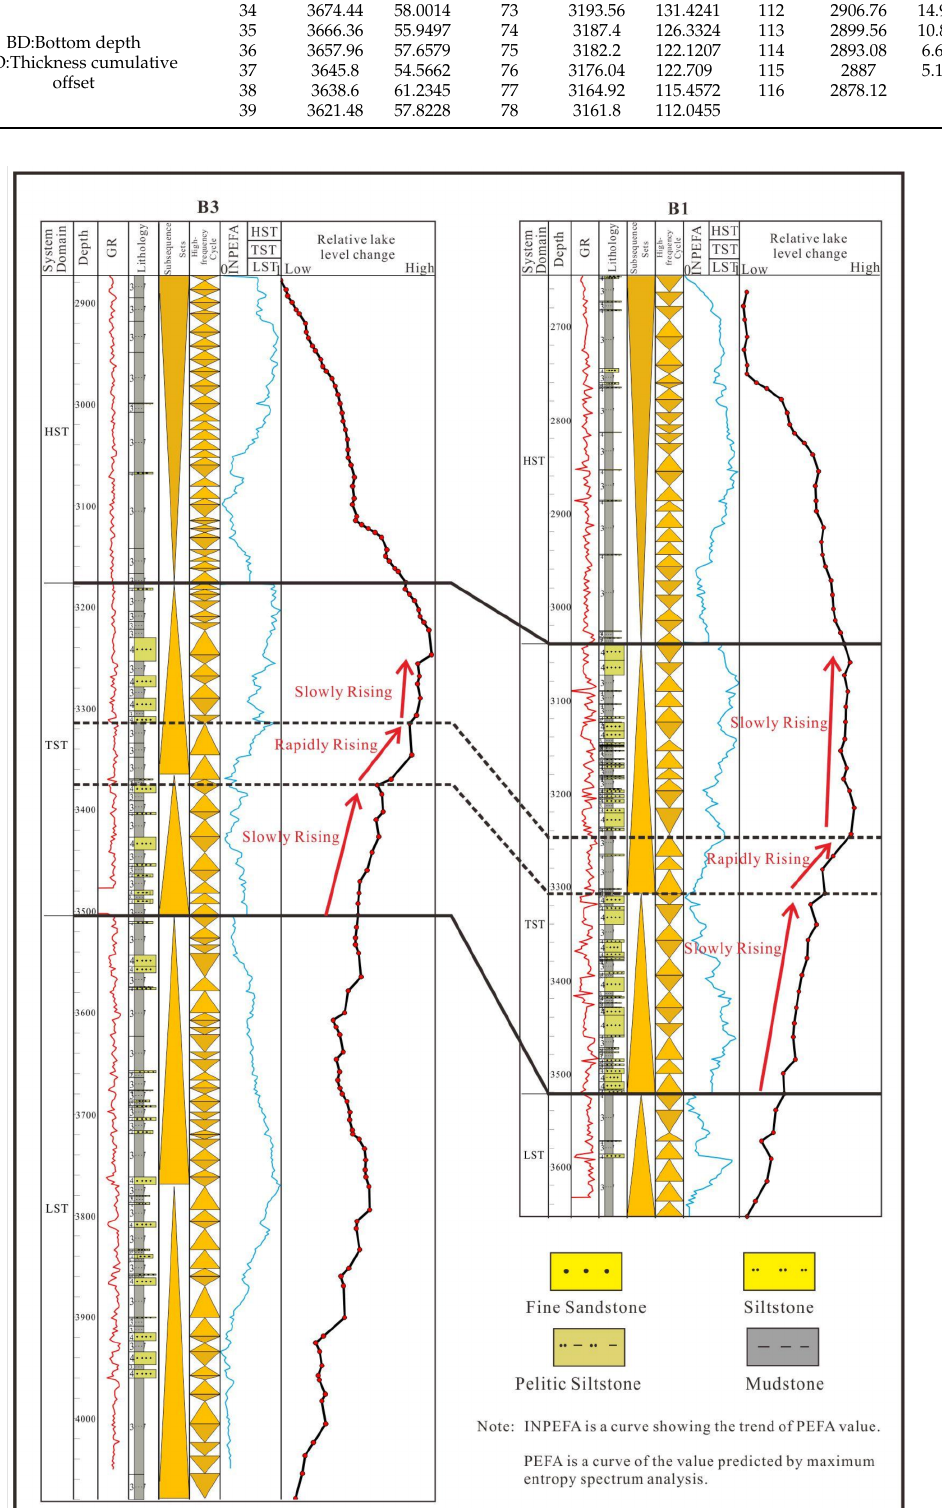
Figure 7. High frequency sequence division scheme and relative lake level change